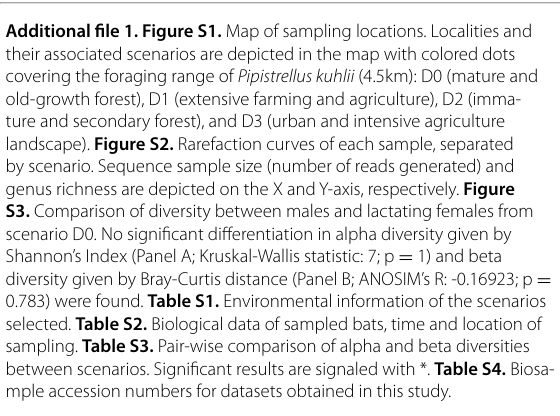
sampling. Table S3. Pair‑wise comparison of alpha and beta diversities between scenarios. Significant results are signaled with *. Table S4. Biosa‑ mple accession numbers for datasets obtained in this